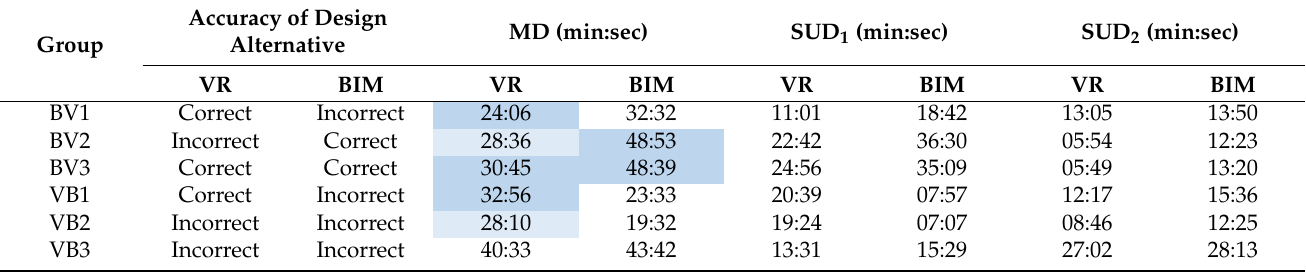
Table 2. Group performance in the platforms of VR and BIM.